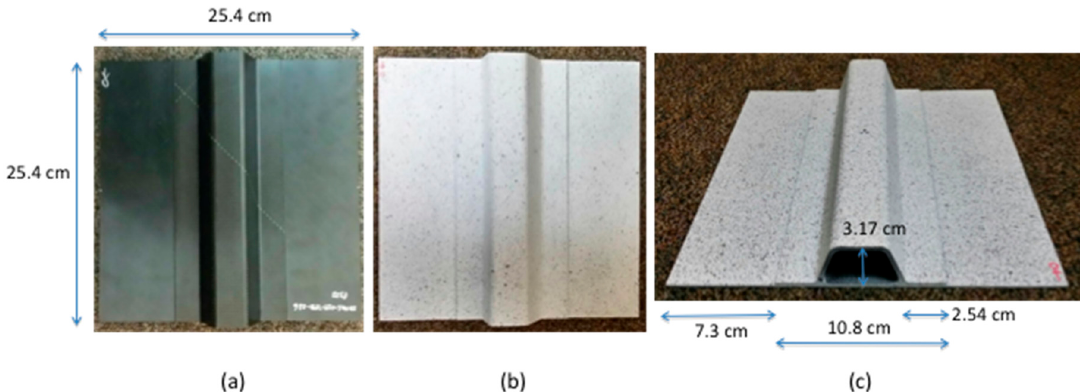
Figure 1. Single stringer hat-stiffened composite panel: ( a ) stringer side; ( b ) stringer side painted for digital image correlation measurements; ( c ) cross sectional side view.